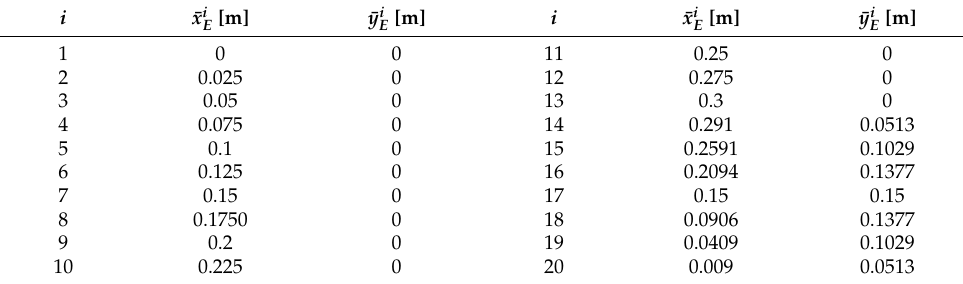
Table A3. Precision points for study case 3: Eight-bar linkage mechanism.